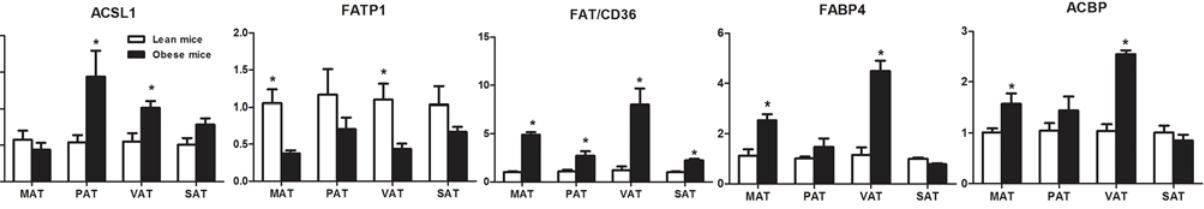
Fig 6. Comparative study of the mRNA levels of ACSL1, FAT, ACBP, FABP3, and FATP1 in MAT, PAT, VAT and SAT between lean and obese mice. The data are presented as the mean ± SEM (n = 3). Asterisks ( * ) indicate significant differences between lean and obese mice ( P < 0.05). ACSL, long-chain fatty acyl-CoA synthetase; FAT, fatty acid translocase; ACBP, acyl CoA binding protein; FABP, fatty acid binding protein; FATP, fatty acid transport